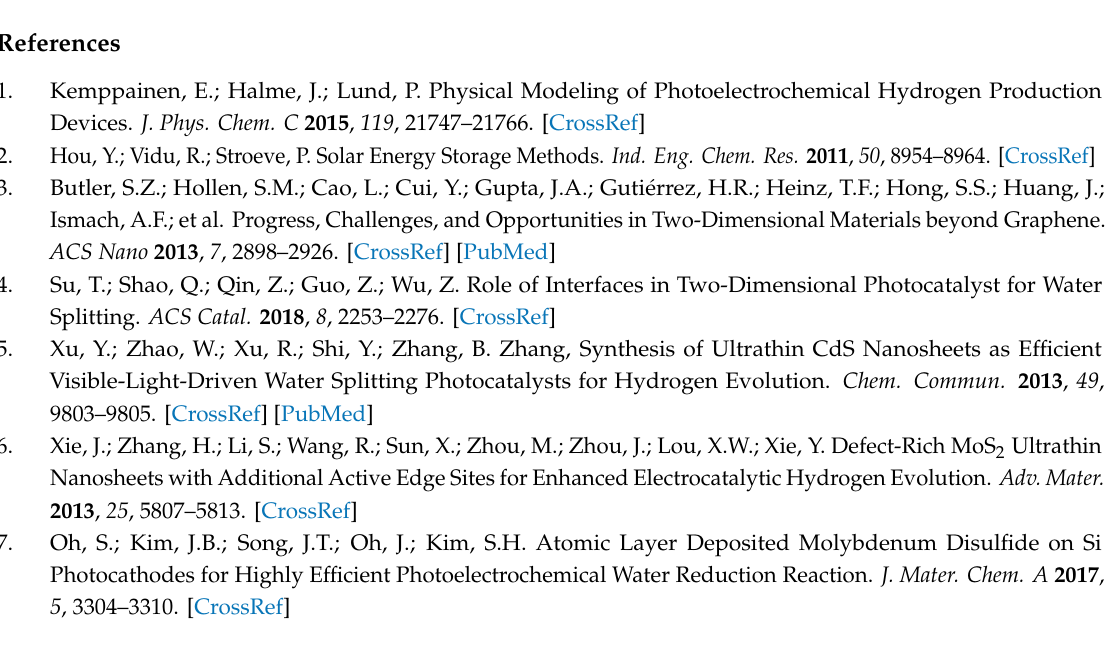
Figure S1: Photos of 50-nm-thick Sn x S y films which in the growth of the glass substrates at di ff erent deposition temperatures. Figure S2: Photoconversion e ffi ciency (a) and IPCE curve (b) of the 50-nm-thick SnS 2 film deposited at 140 ◦